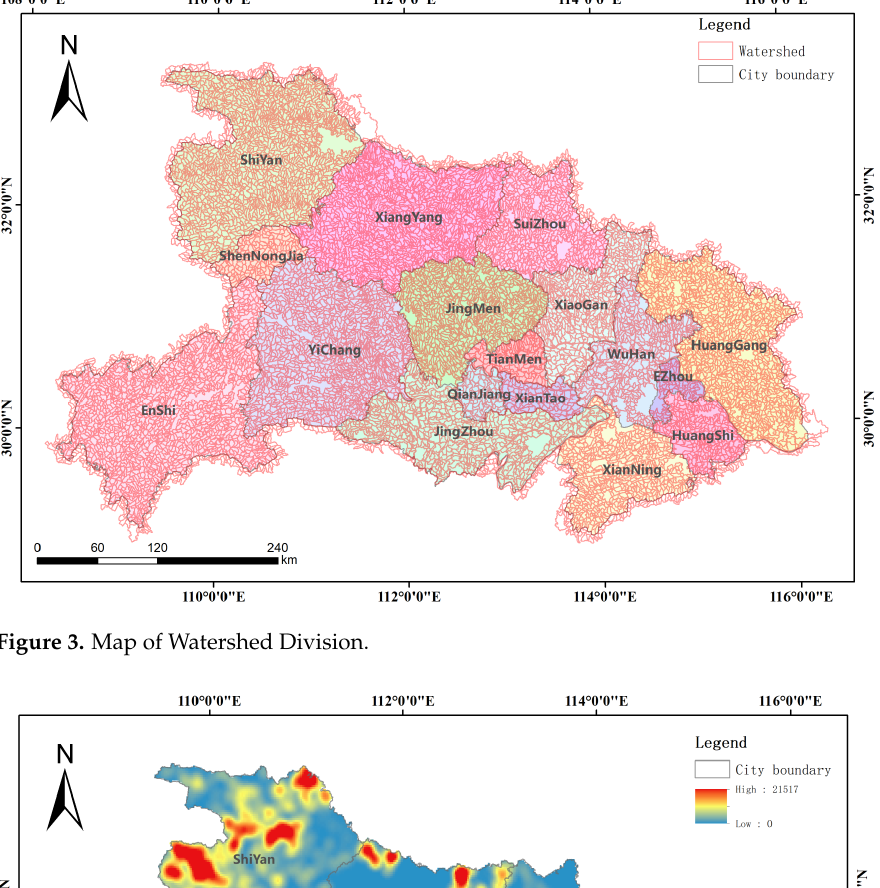
Figure 3. Map of Watershed Division.